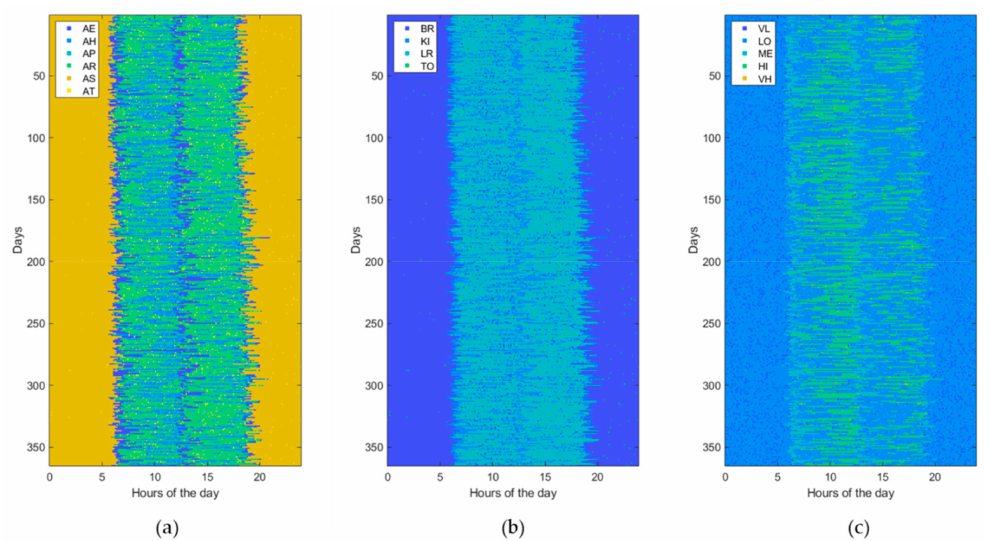
Figure 5. The same normal dataset shown in Figure 4 but represented with di ff erent images for ( a ) activity of daily living (ADL), ( b ) home locations (LOCs), and ( c ) heartrate levels